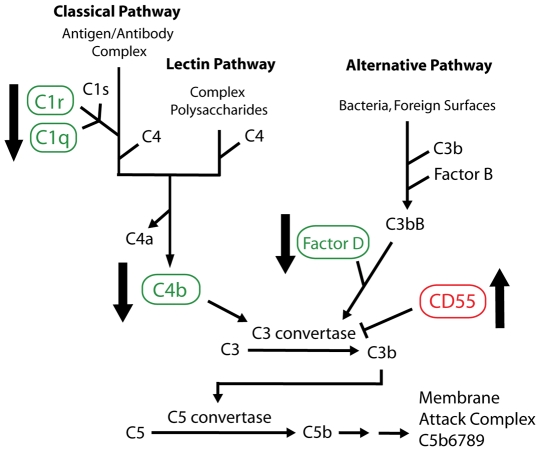
Effects of PAR2 activation on complement pathways.Relationship between genes regulated by PAR2 (black arrows) and classical, alternative and lectin pathways of complement activation. Five key genes regulated by PAR2 activation were C1q, C1r, C4b, factor D and CD55 (decay accelerating factor). C1r/q subunits of C1 are in the classical pathway; C4b is essential for formation of C3 convertase in the classical and lectin pathways; Factor D is similarly important for C3 convertase in the alternative pathway; CD55 actively breaks down C3 convertase contributing to anti-complement effects of PAR2. Such regulation of all these genes will limit formation of pro-inflammatory anaphylatoxins (C3a, C5a) and membrane attack complex.